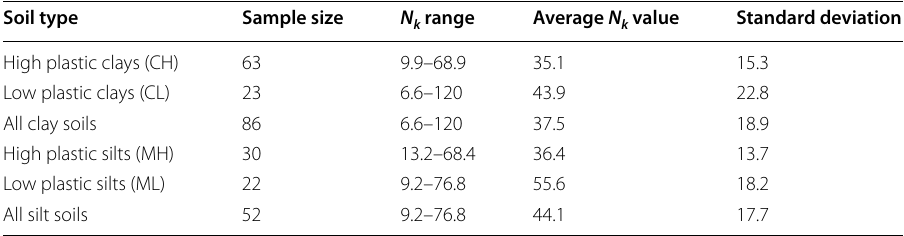
for different soils k